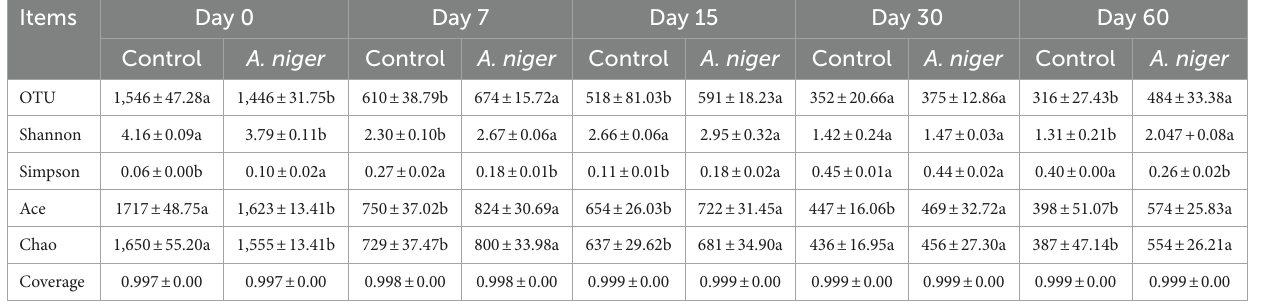
TABLE 2 Alpha diversity in ratooning sorghum ensiled with A. niger for different days.